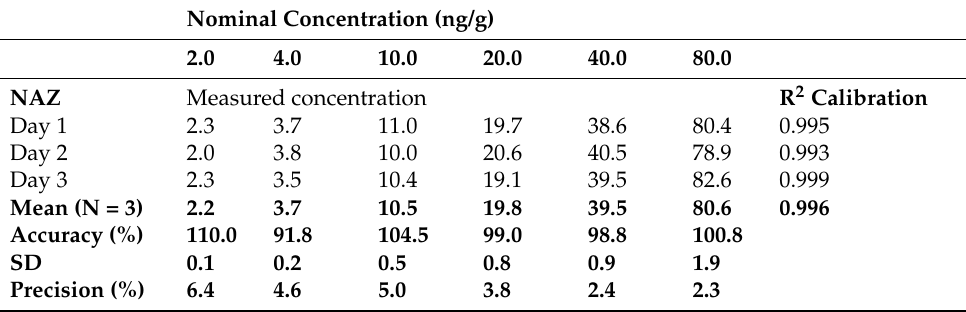
Table 2. Linearity, accuracy, and precision of the NAZ calibration curve in brain tissue.